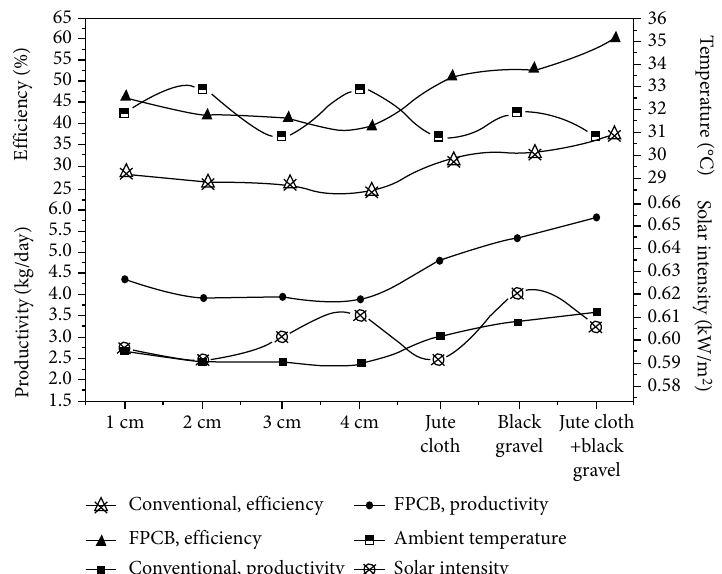
Figure 9: E ff ect of di ff erent parameters in the conventional solar still and the fl at plate collector coupled with a solar still [58].